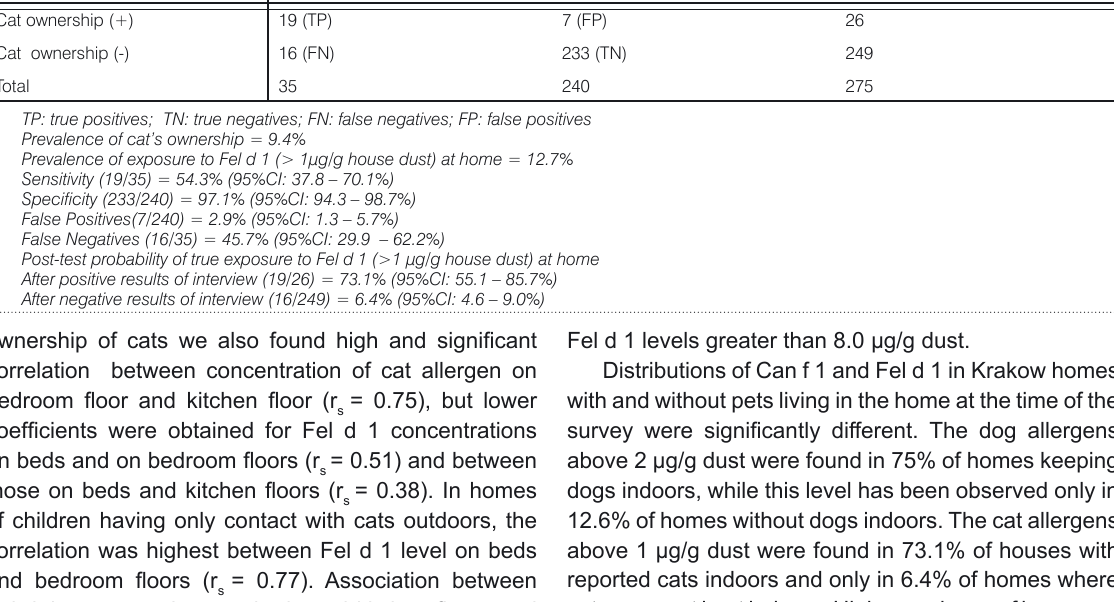
Table 4. Interview on the ownership of pets for prediction of risk of exposure to Fel d 1 allergen (concentration >1.0 µg/g house dust) at homes of children.